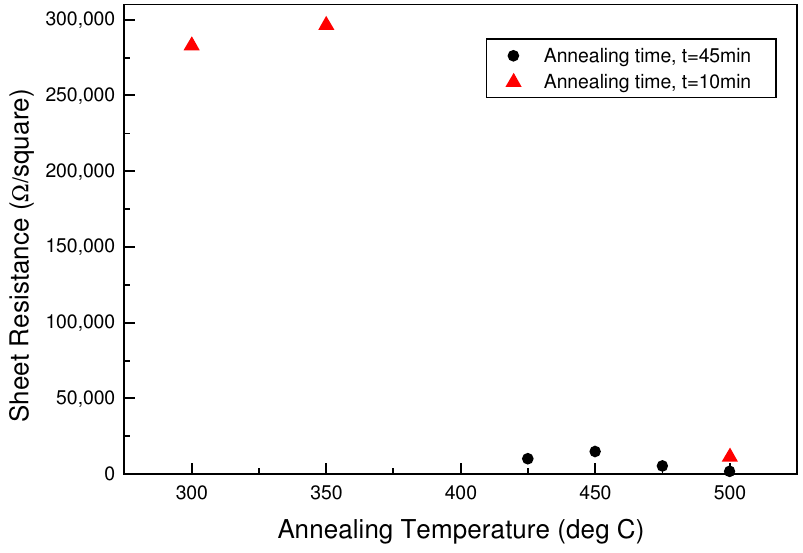
Figure 6. Sheet resistance of obtained samples (with spin-coating 1 times, annealing time of 10min and 45min